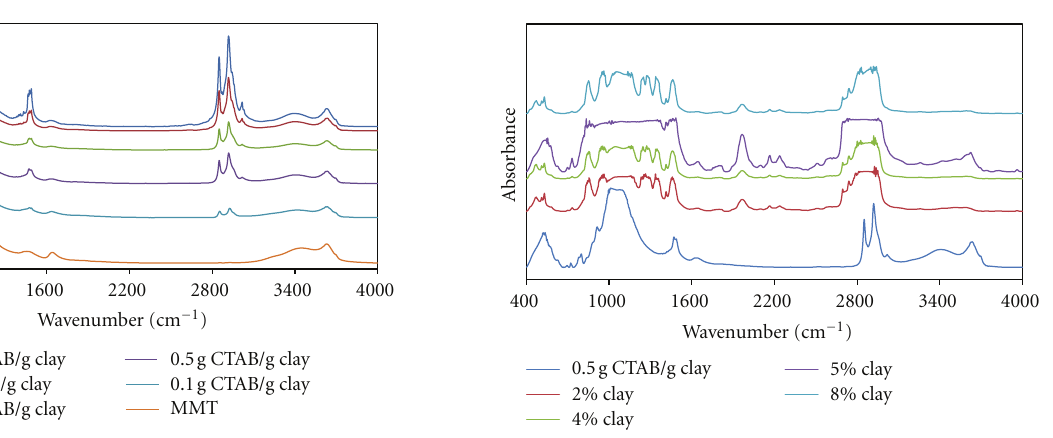
Figure 9: FTIR spectra of produced PEO/clay nanocomposites at various clay compositions (0.5 g CTAB/g clay ratio).